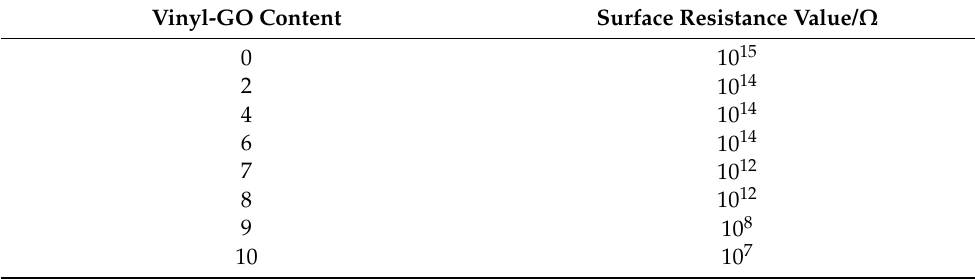
Table 2. The surface resistance values of SR/vinyl-GO nanocomposites.